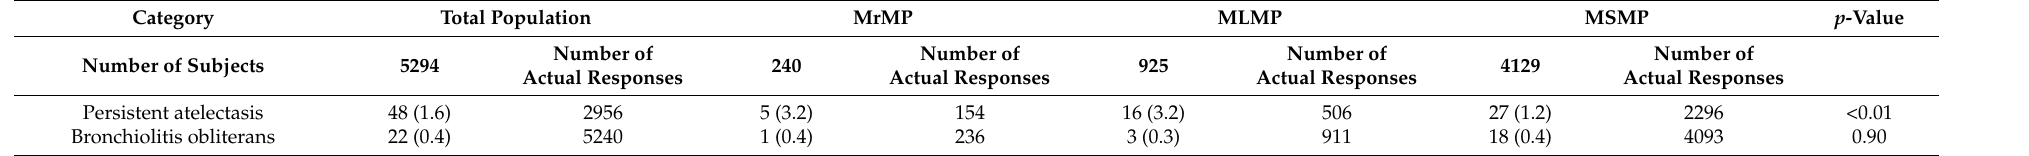
Table 7. Postinfectious pulmonary sequelae after Mycoplasma pneumoniae